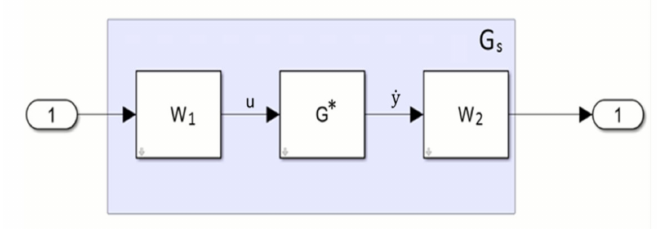
Figure 3. Shaped